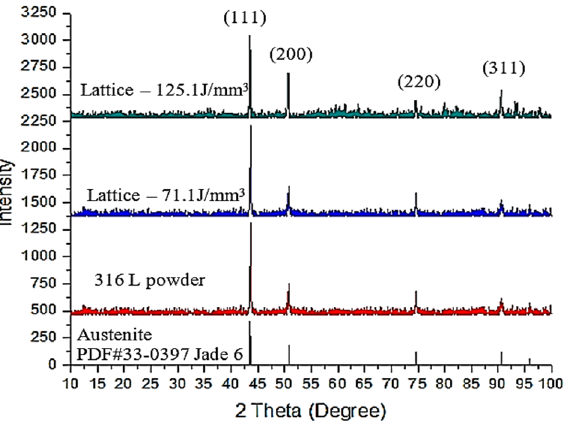
Figure 5. X-ray diffraction patterns of as-received powder built object by laser energy density of 71 J/mm 3 and 125 J/mm